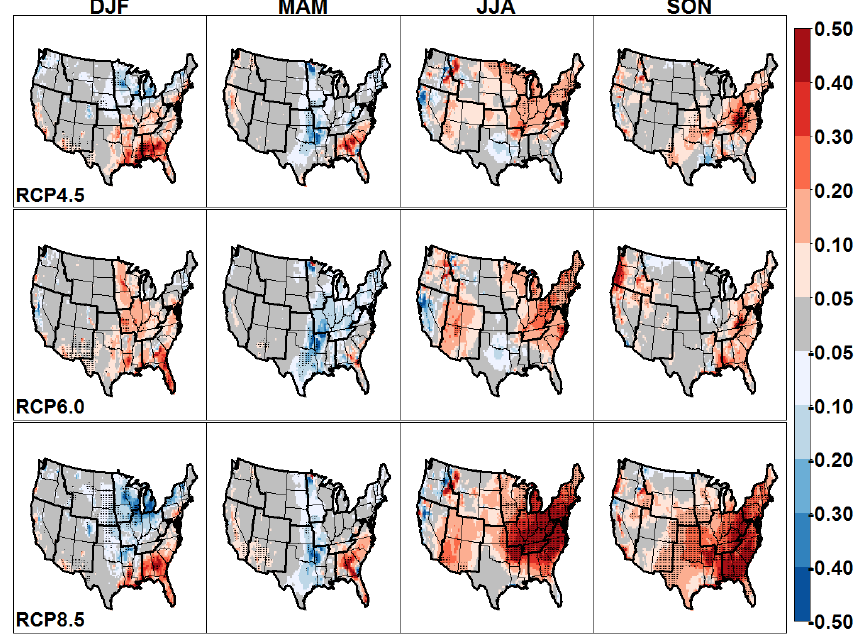
Figure 9. Changes in seasonal mean concentrations (µgm − 3 ) of PM 2 . 5 organic matter under three RCP scenarios. Dark pixels indicate where differences are significant according to Student’s t test ( p < 0 .